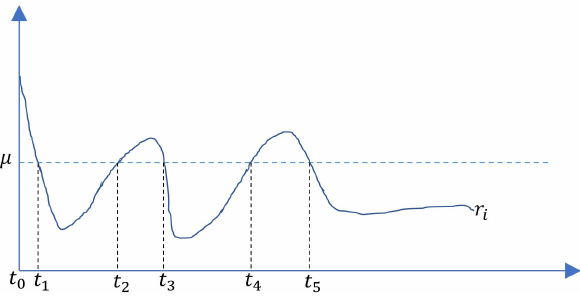
Figure 1. The indices on error